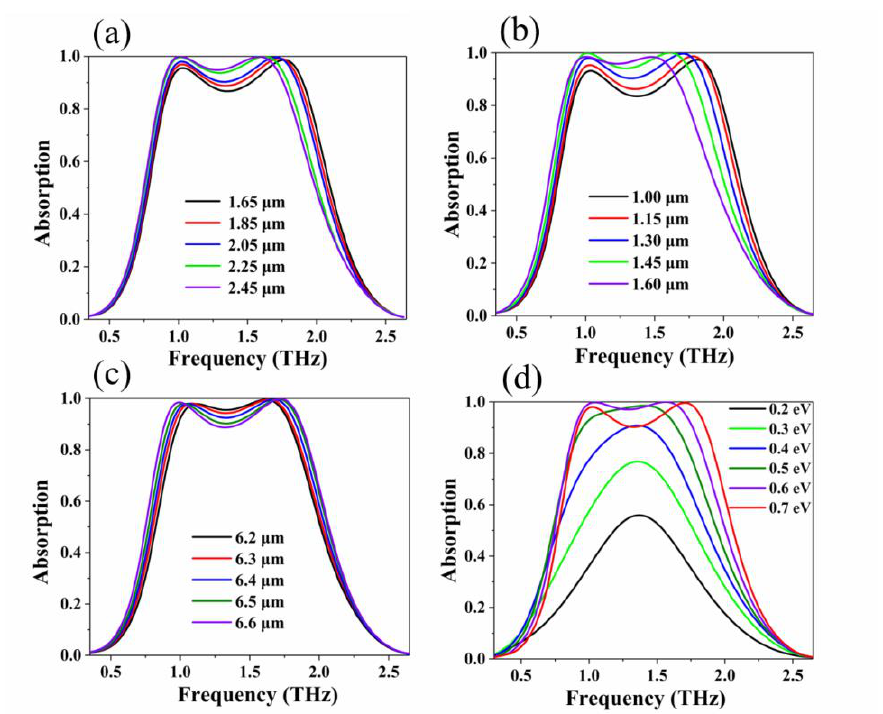
Figure 5. Simulated geometric parameters of terahertz wave absorber and graphene Fermi level. ( a ) The value of the inner circle radius r of the graphene ring, ( b ) the value of the small circle radius p within the graphene ring, ( c ) the value of the outer diameter R of the graphene ring, ( d ) Simulated absorption at different Fermi levels E f from 0.2 eV to 0.7 eV of graphene.